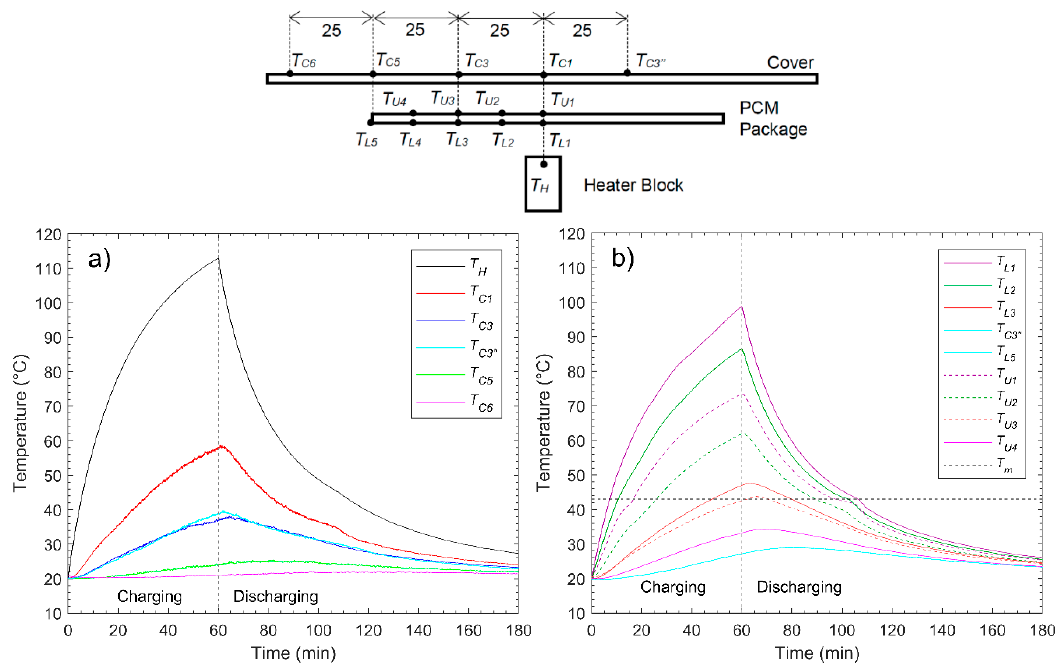
Figure 5. ( a ) Temperature profile of the heater ( T H ) and the cover surface ( T C ); ( b ) Temperature profiles of the upper ( T U1 –T U4 ) and lower ( T L1 –T L5 ) surface of the PCM package B (dodecanoic acid) for the experiment with a constant power input of 5 W for 60